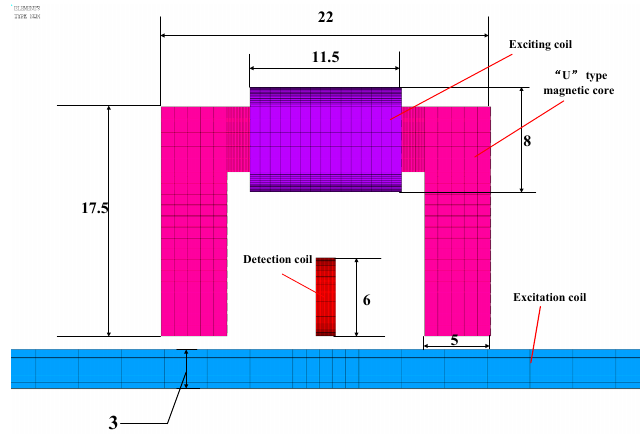
Figure 3. Three-dimensional simulation model size diagram.